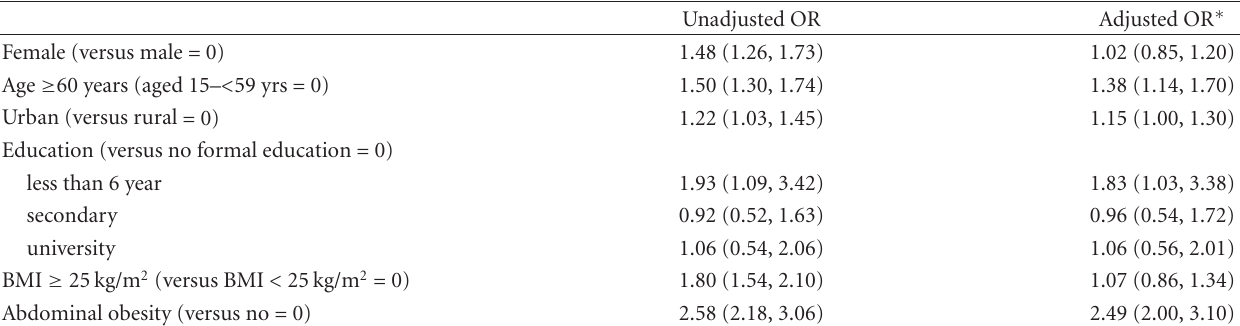
Table 4: Factors associated with coexistence of hypertension and diabetes compared to those having either diabetes or hypertension alone. Unadjusted